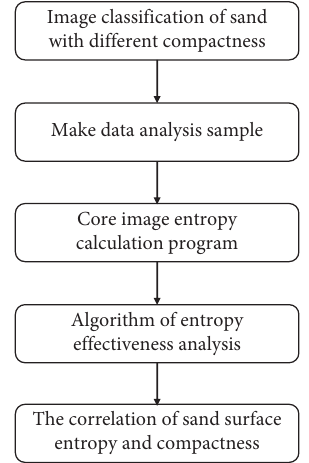
Figure 3: Correlation analysis